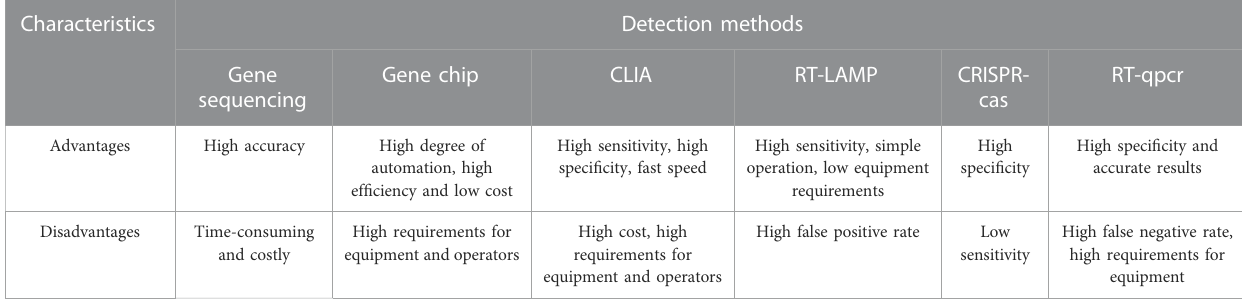
TABLE 3 Comparisons of advantages and disadvantages of various SARS-Cov-2 diagnosis methods.